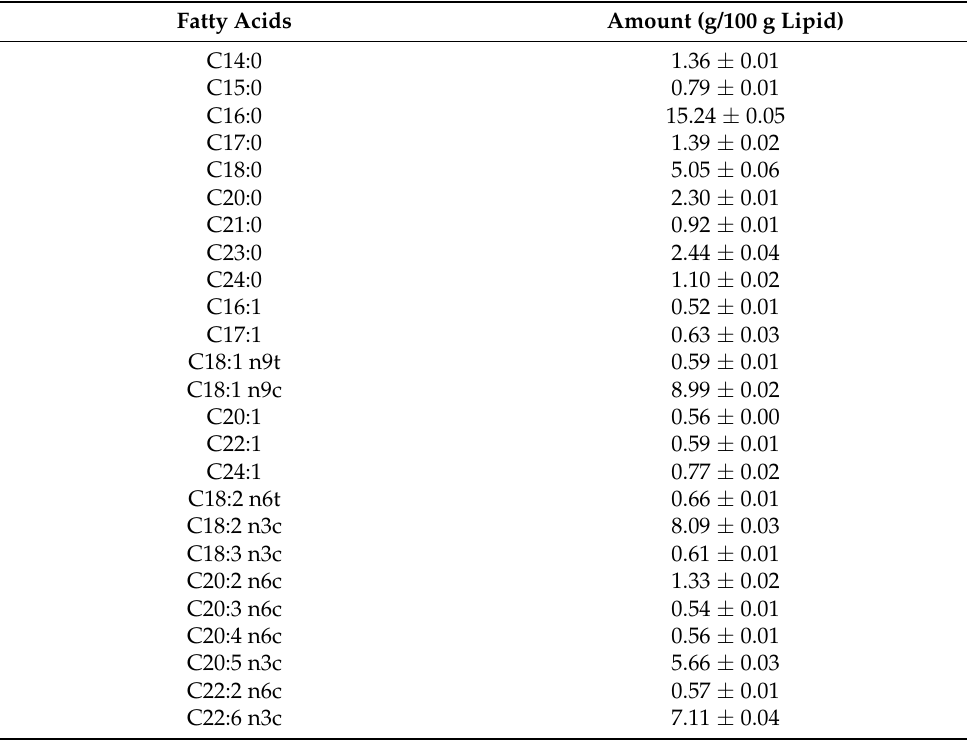
Table 1. Fatty acid profile and astaxanthin content of lipids extracted from the cephalothorax of Pacific white shrimp.